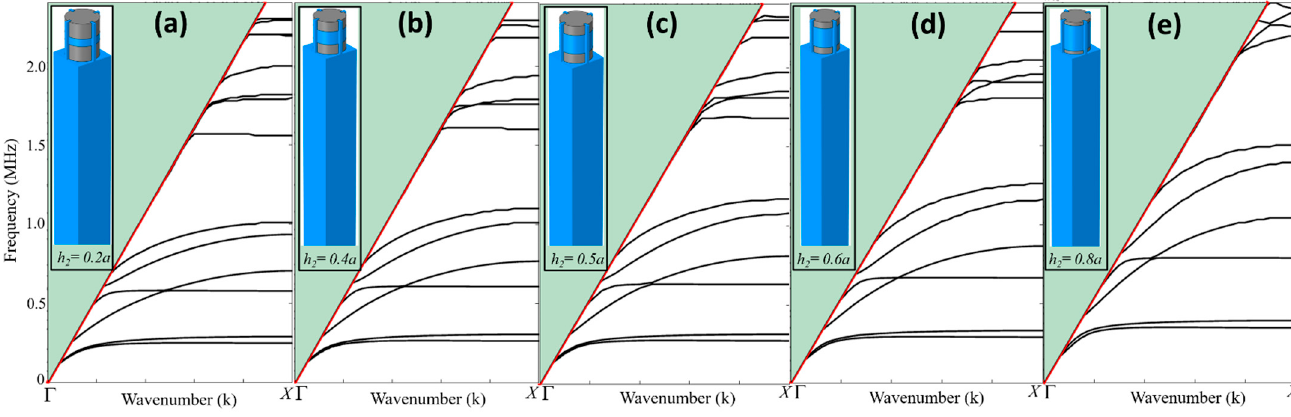
Figure 6. SAW band structures for ( a ) h 2 = 0.2 a ; ( b ) h 2 = 0.4 a ; ( c ) h 2 = 0.5 a (parent structure); ( d ) h 2 = 0.6 a ; and ( e ) h 2 = 0.8 a . One can deduce identical vibration modes as reported for the parent structure in Figure